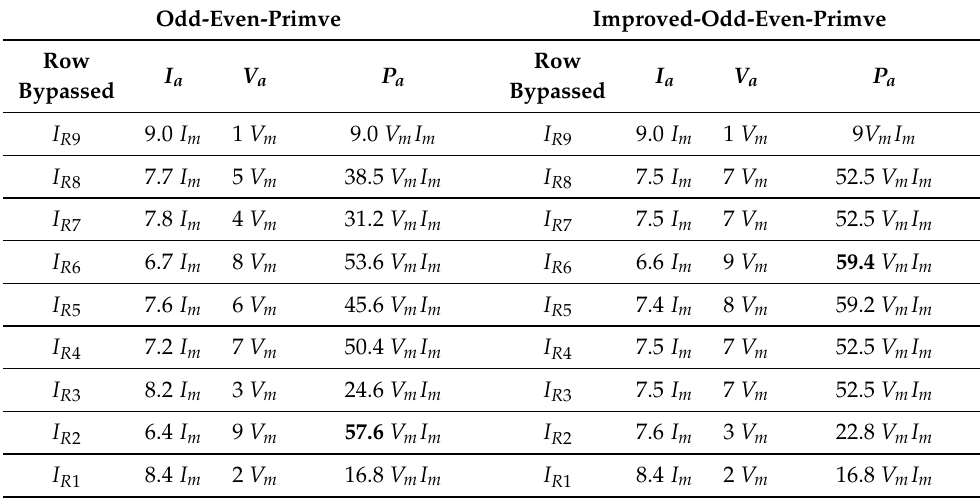
Table 3. GMPP for 9 × 9 PV array for Case-2 (Top-Right) PSC. Odd-Even-Primve